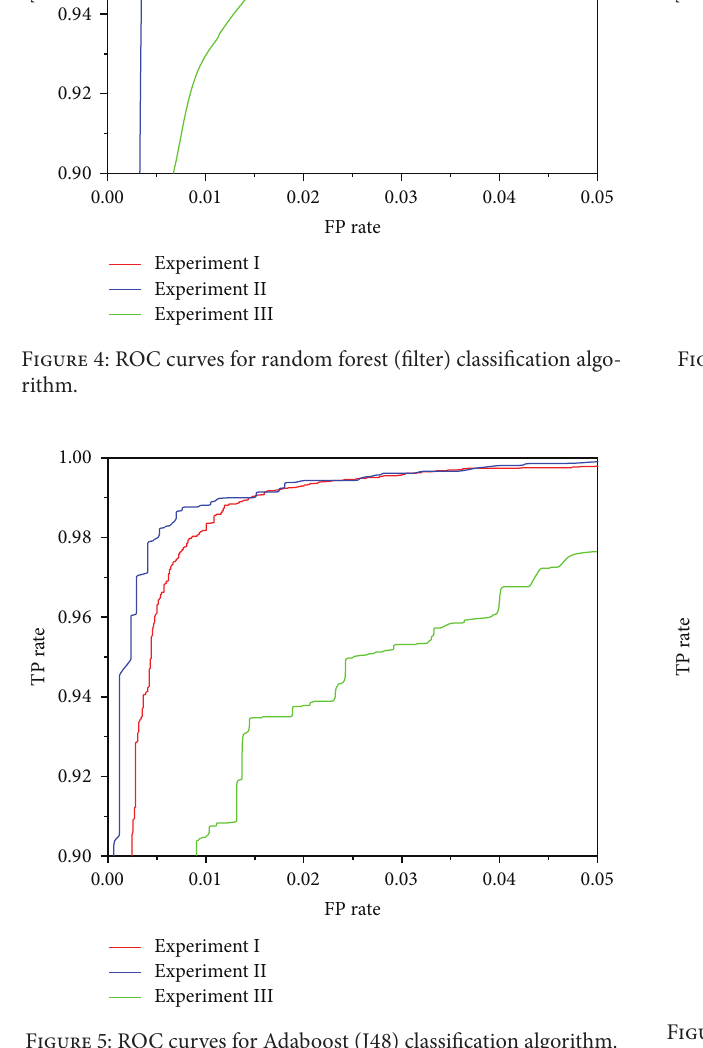
Figure 5: ROC curves for Adaboost (J48) classification algorithm.